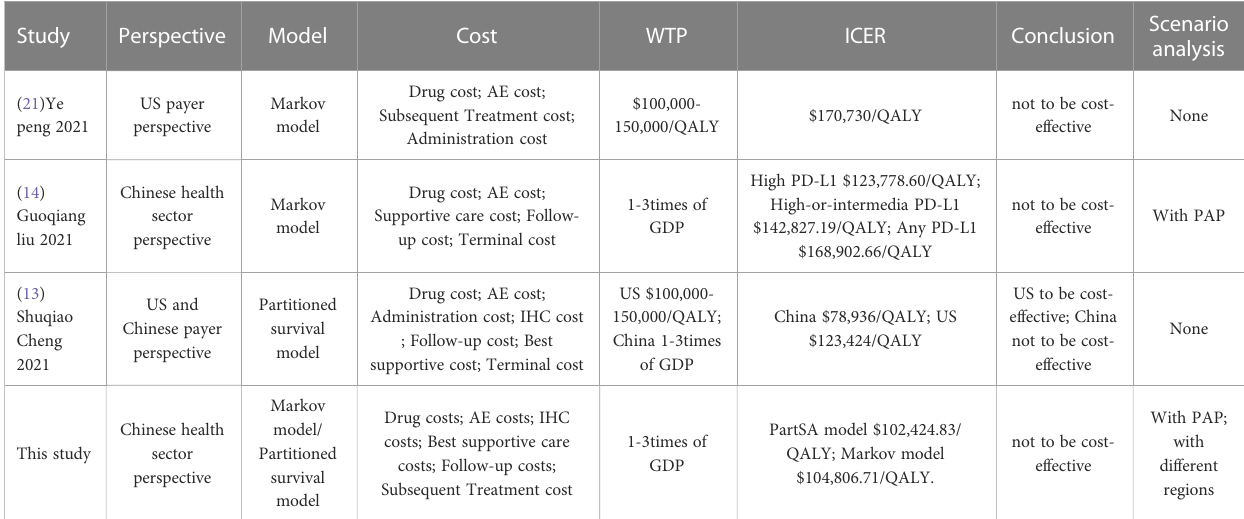
TABLE 5 Comparison of published